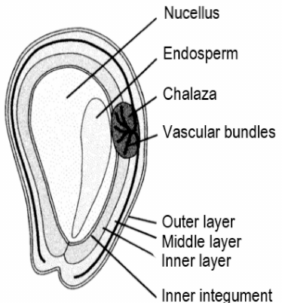
Figure 3. Structure of grape seeds